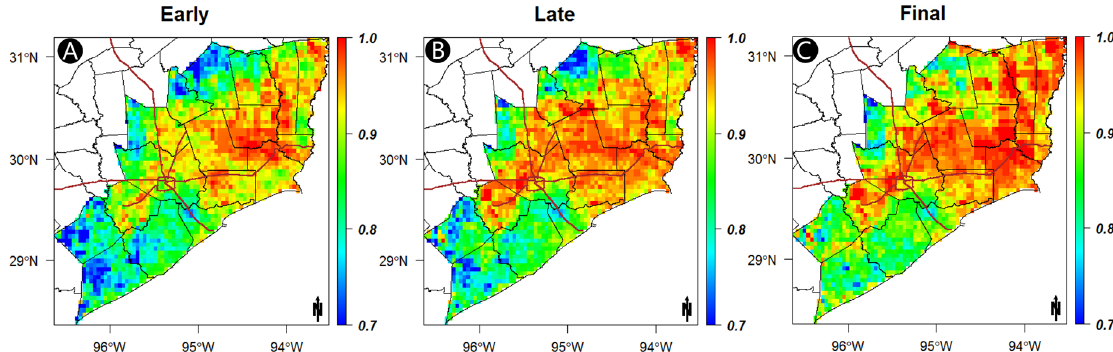
Figure 10. Spatial distribution of POD for the IMERG ( A ) Early-, ( B ) Late-, and ( C ) Final-run products during Tropical Storm Imelda.